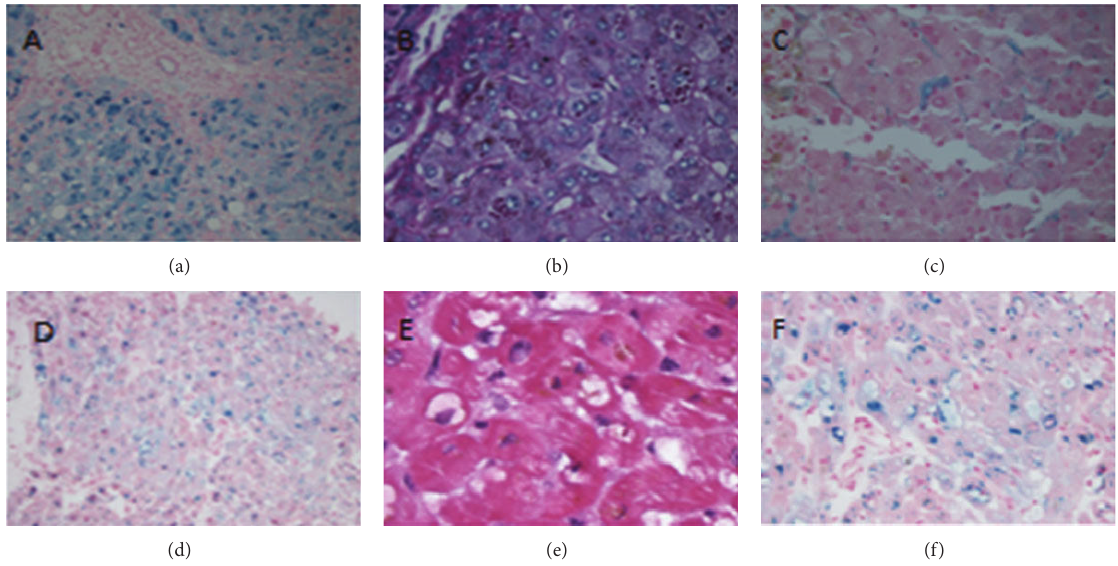
Figure 1: (a) Prussian-Blue stain showing iron granules in hepatocytes and bile duct epithelium in the explanted liver. (b) PAS-Diastase stain showing alpha 1 antitrypsin globules in periportal hepatocytes in the explanted liver. (c) Prussian-Blue stain showing iron granules in Kuppfer cells in the transplanted liver. (d) Prussian-Blue stain with extensive cytoplasmic iron in cardiac myocytes. (e) Hematoxylin and Eosin stain with intracytoplasmic hemosiderin in myocytes. (f) Prussian-Blue stain high power view of cytoplasmic iron in cardiac myocytes.